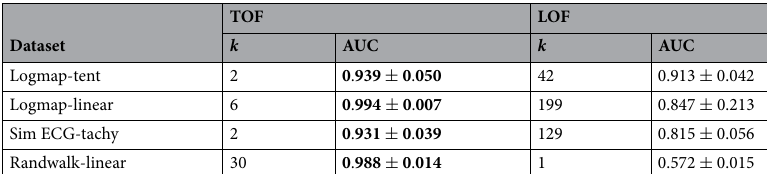
Table 1. Detection performance on simulations in terms of ROC AUC scores and the optimal neighborhood parameter k . Maximal mean ROC AUC values and the corresponding SDs are shown. LOF was able to distinguish tent map and linear outliers from logistic background and tachycardia from the normal rhythm with reasonable reliability but TOF outperformed LOF for all data series. Linear outliers can not be detected on random walk background by the LOF method at all, while TOF detected them almost perfectly. TOF reached its maximal performance mostly for low k values, while LOF required larger k for optimal performance on those three data series, on which it worked reasonably. While the ROC AUC was maximal at k = 30 in the case of random walk with linear outlier, the performance was not significantly lower for lower k